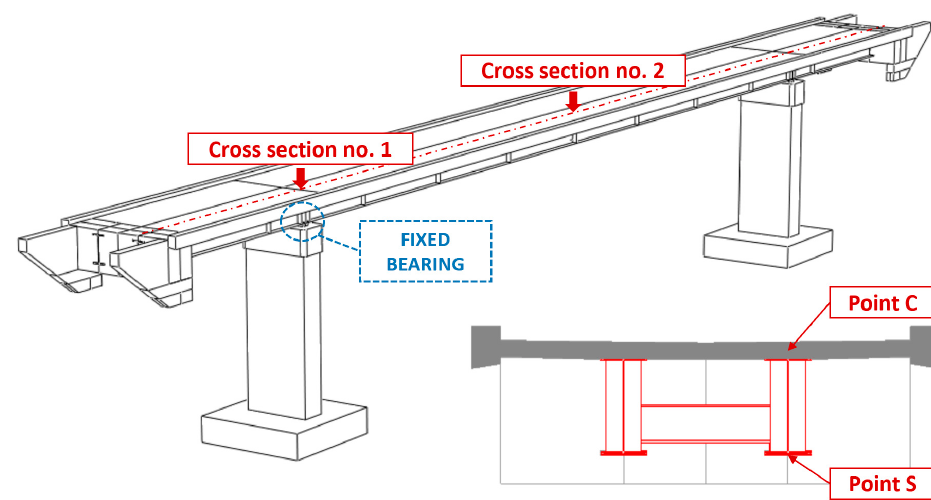
Figure 20. Representative points of the footbridge selected for the dynamic analyses.